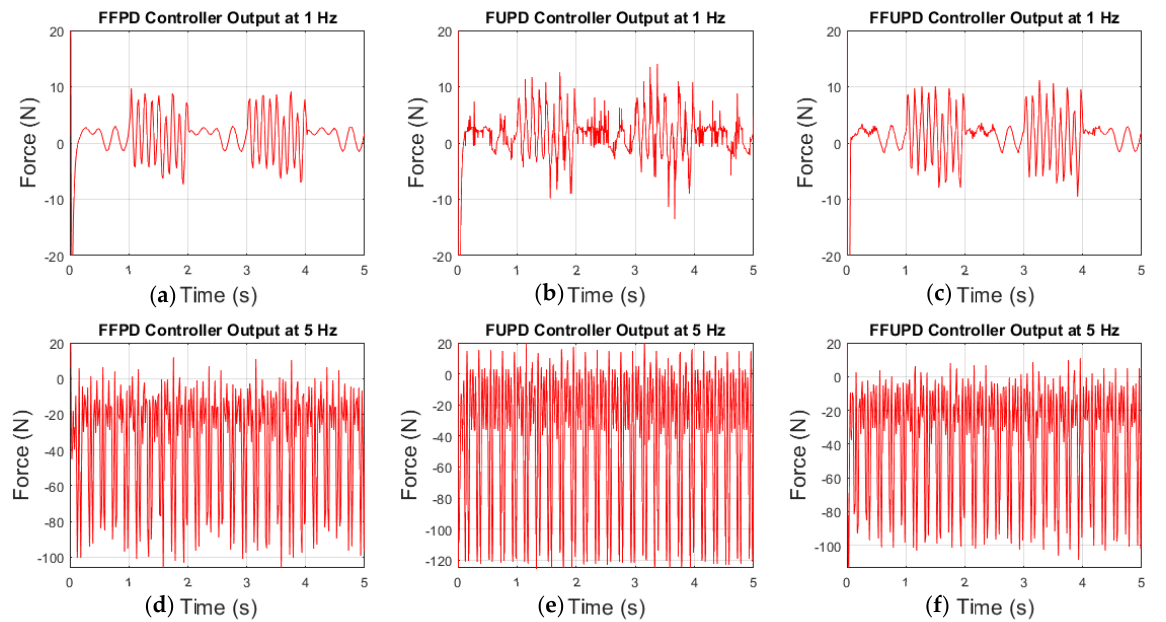
Figure 16. Control action taken by FFPD, FUPD and FFUPD when sinusoid disturbance was applied to limb 2 when: ( a – c ) platform was flapping at 1 Hz and ( d – f ) platform was flapping at 5 Hz.